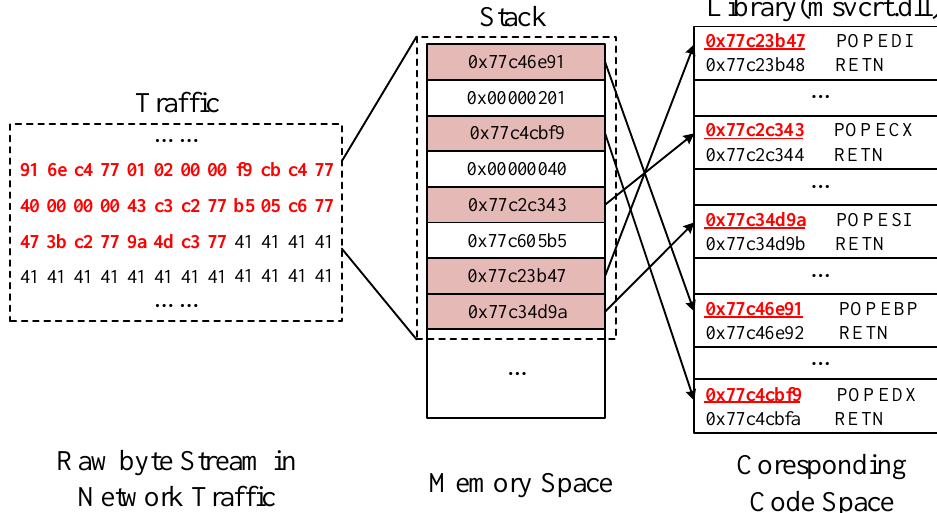
Figure 1. A typical example of code-reuse exploit with ROP